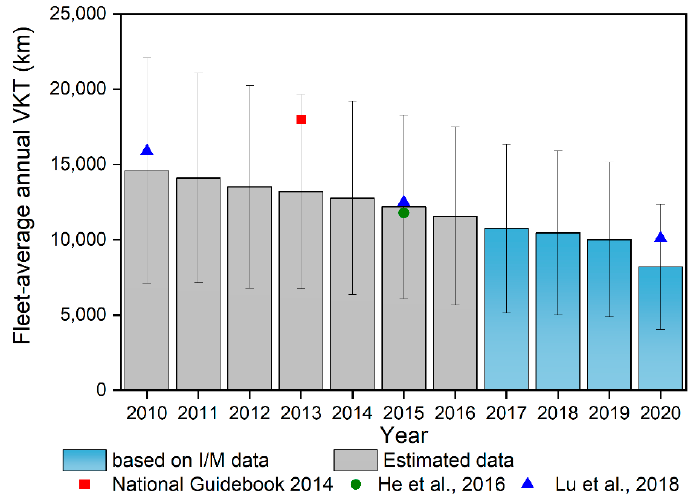
Figure 6. Fleet-averaged VKT trends of LDPV from 2010 to 2020 [11,16,23].